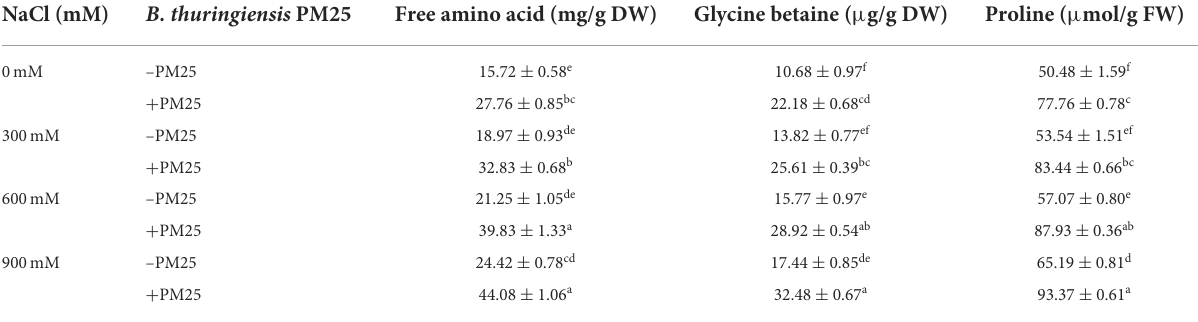
TABLE 6 Level of osmolytes in the presence and absence of Bacillus thuringiensis PM25 under salinity